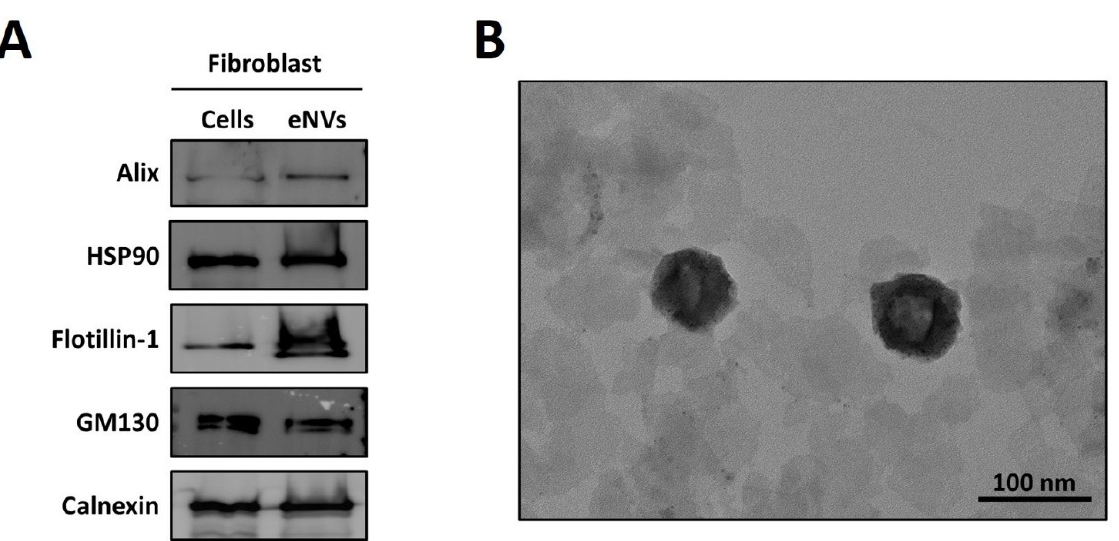
Figure 2. Characterization of engineered nanovesicles of fibroblasts. ( A ) Western blot analysis of fibroblasts and FB-eNV lysates for the detection of EV biomarkers (Alix, HSP90, and Flotillin-1) and cellular markers (GM130 and calnexin). ( B ) Transmission electron microscopy image of eNVs (scale bar: 100 nm).